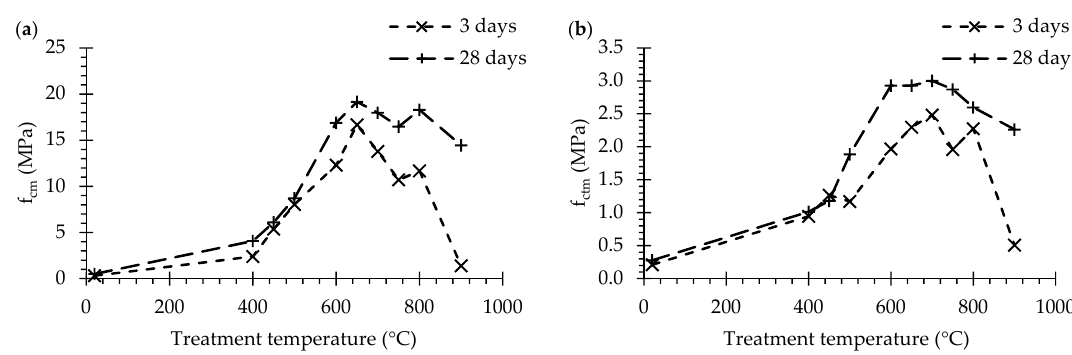
Figure 12. Mechanical properties of RC pastes at 3 and 28 days: ( a ) compressive strength, f cm ; ( b ) flexural strength, f ctm .